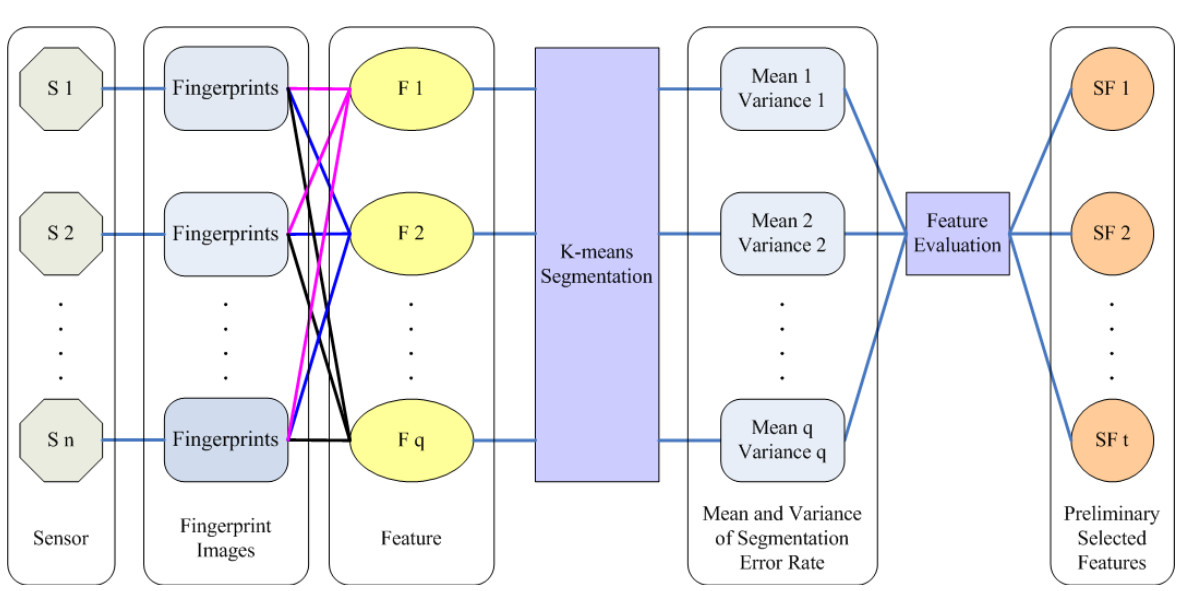
Figure 4. Framework of the first level